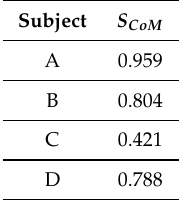
Table 2. DFS-based symmetry index values of the vertical CoM for all